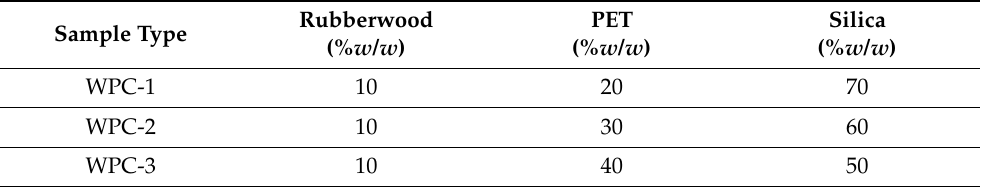
Table 1. The composition of WPC